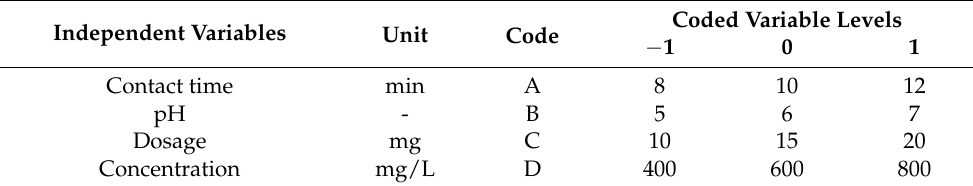
Table 2. Independent variables and levels in the experimental